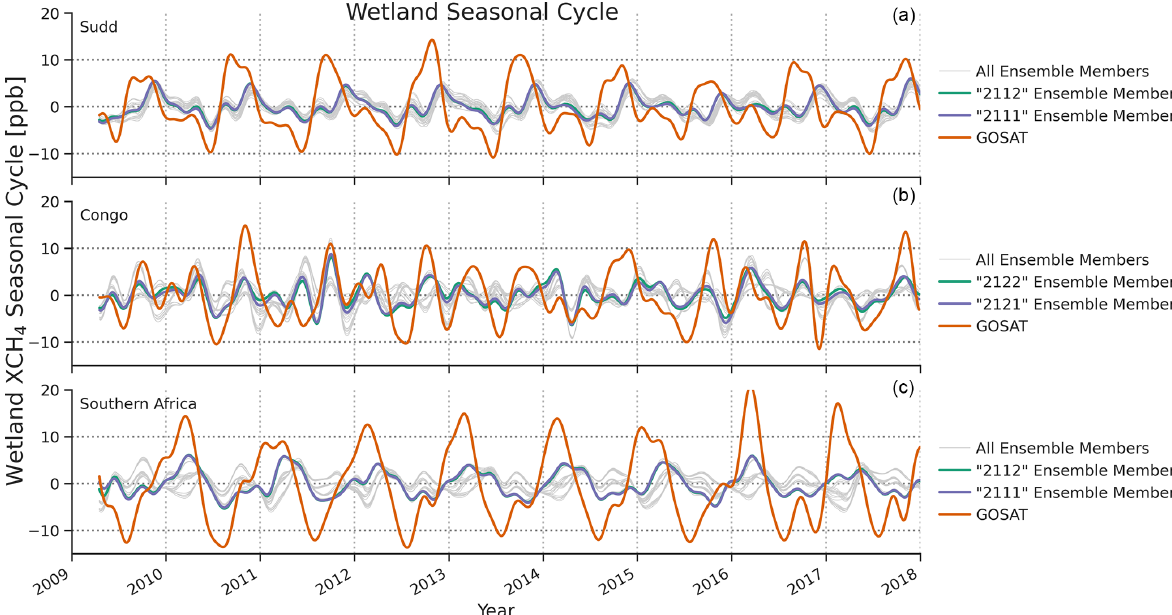
Figure 8. Time series showing the GOSAT (red) and JULES ensemble (grey) wetland CH 4 seasonal cycles for the three African wetland regions. The wetland seasonal cycle is calculated by subtracting the TOMCAT model simulations that do not contain any wetland emissions. For each region, the best performing (highest R cycle ) ensemble members are shown for the JULES and JULES-SWAMPS wetland extent configurations.